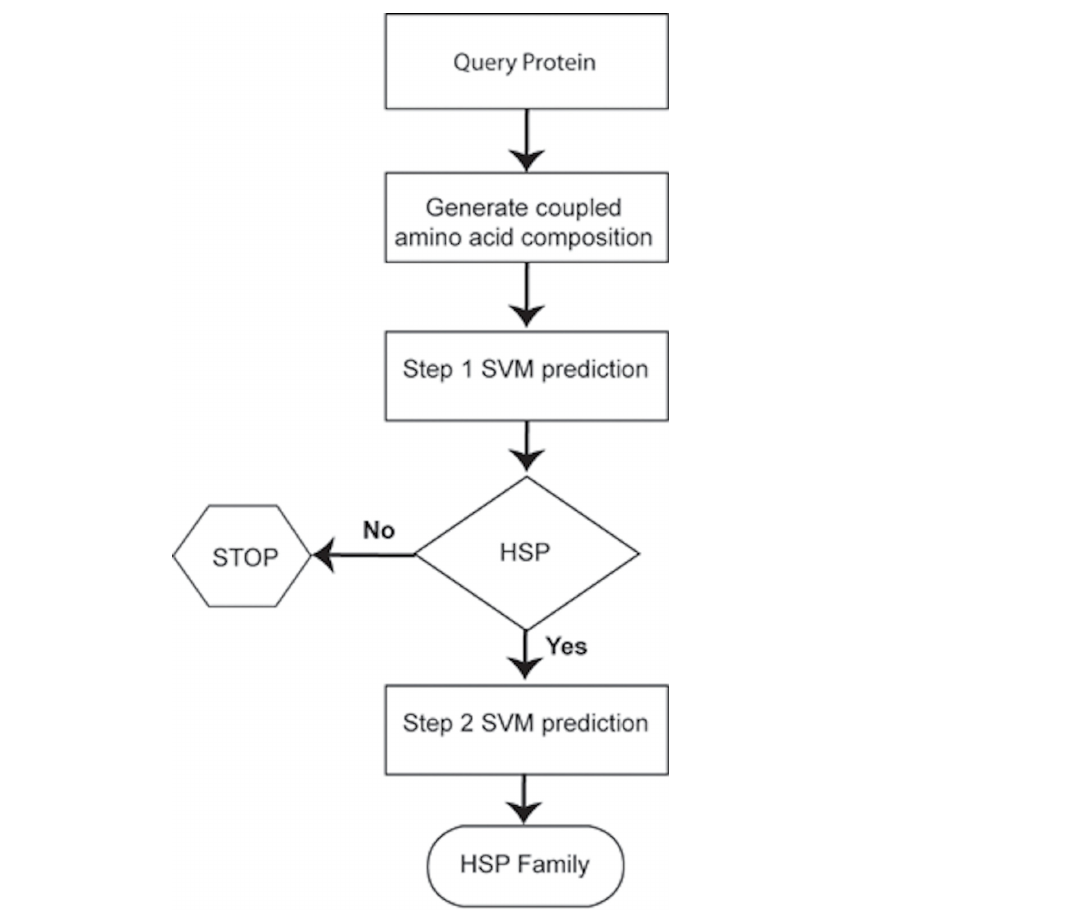
Fig 1. Flow chart to show the prediction schema of HSPs and its